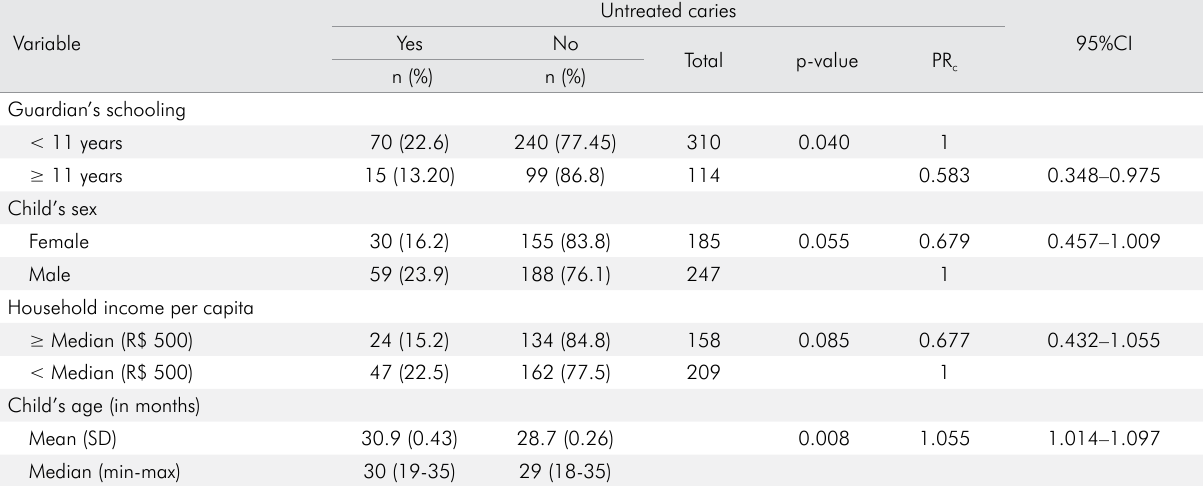
Table 2. Univariate poisson analysis with robust variance of association between socioeconomic variables and prevalence of